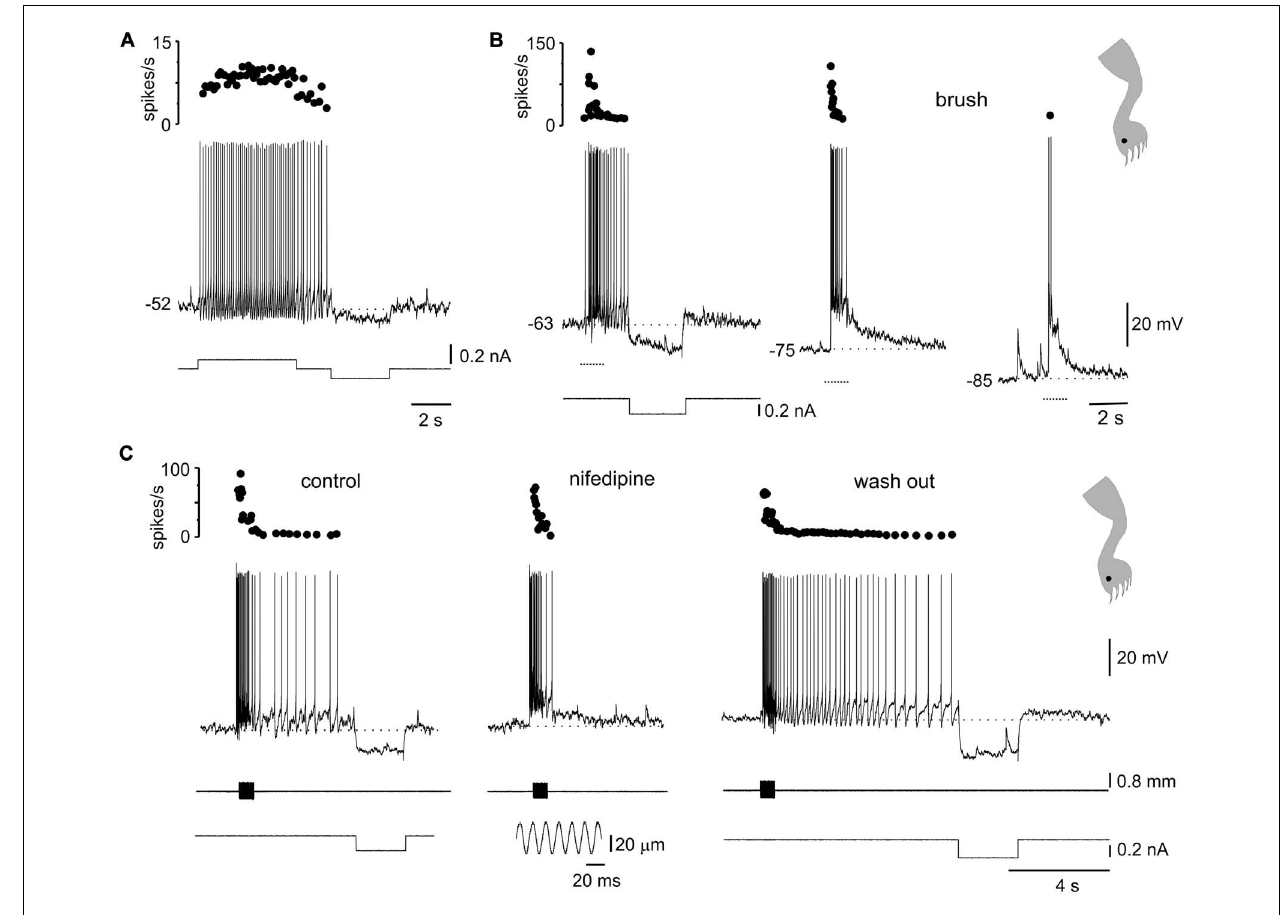
within the receptive field (cartoon in inset on the right) activated the plateau potential as suggested by the prolonged after-discharge terminated by a hyperpolarizing current pulse (control). Nifedipine (40 μ M) spared the earliest component of the response induced by natural stimulation but blocked the prolonged after-discharge which reappeared after wash out. All data from the same